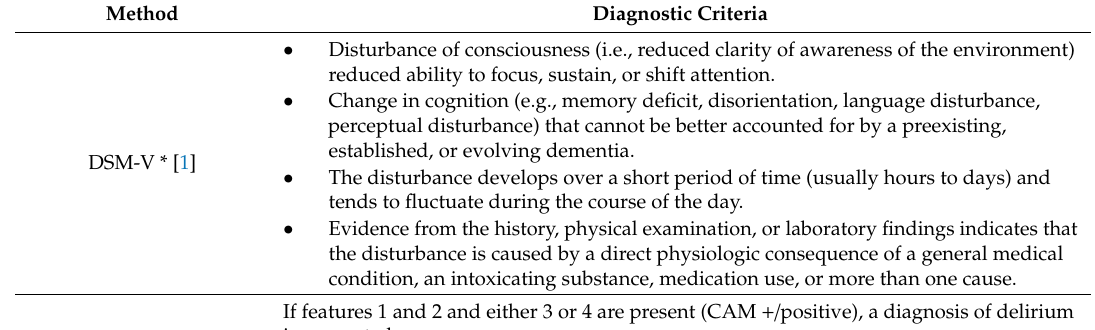
Table 1. Criteria for the diagnosis of delirium in scientific